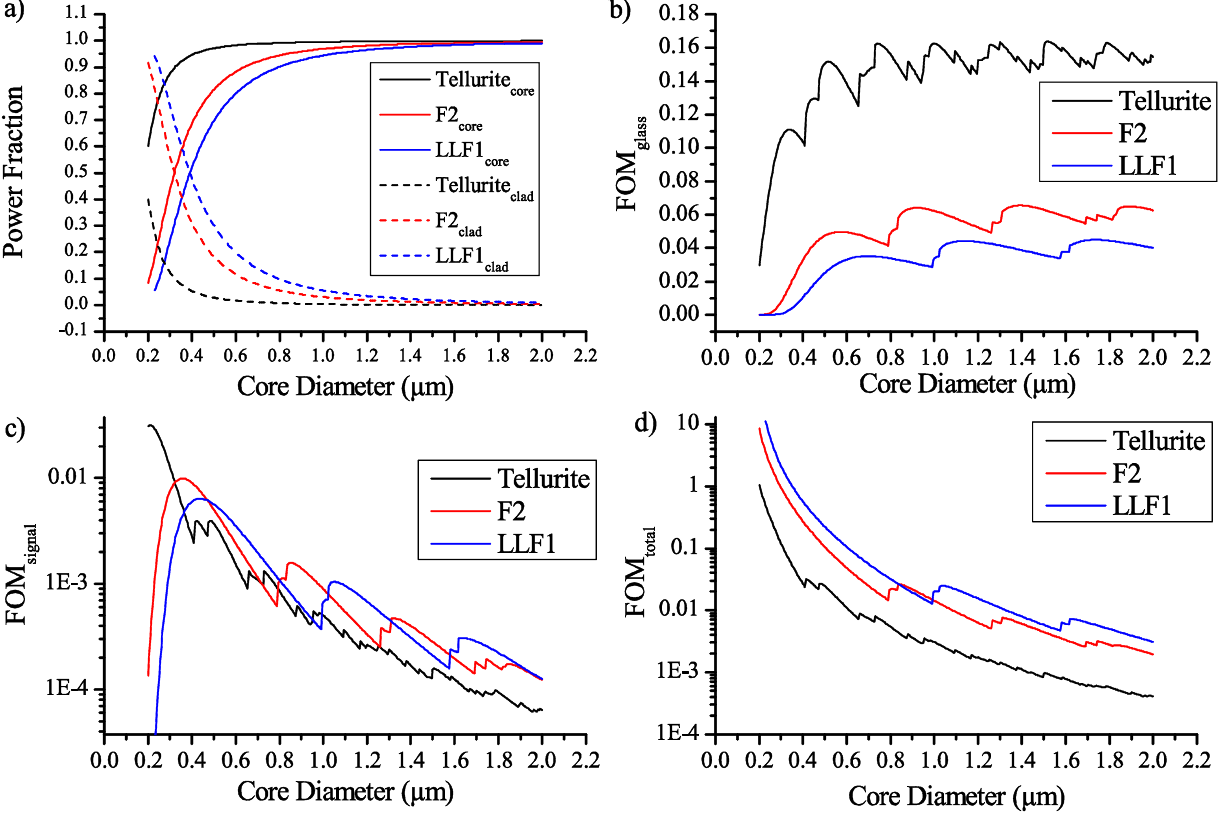
Figure 7. (a) Power fraction at the excitation wavelength located within the cladding or core for various glasses, decane filled. (b) Figure of Merit (FOM) for fluorescent photons excited within the core of the fiber, this represents the intrinsic glass fluorescence. (c) FOM for fluorescent photons excited within the holes—this represents the Qdot fluorescence. (d) Total FOM for the sensing system, with a higher value corresponding to a higher Qdot signal fluorescence relative to the background glass